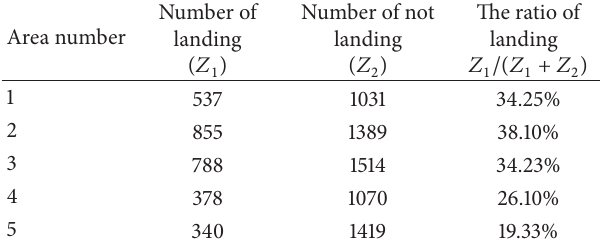
Table 2: The number of OPs in five